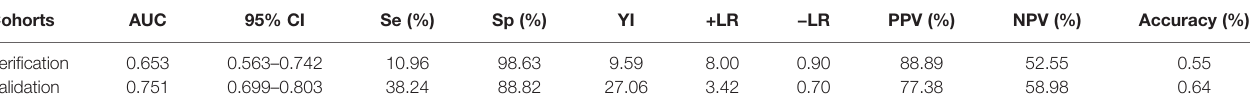
TABLE 2 | The diagnostic value of anti-GNA11 autoantibody in two stages of validation.